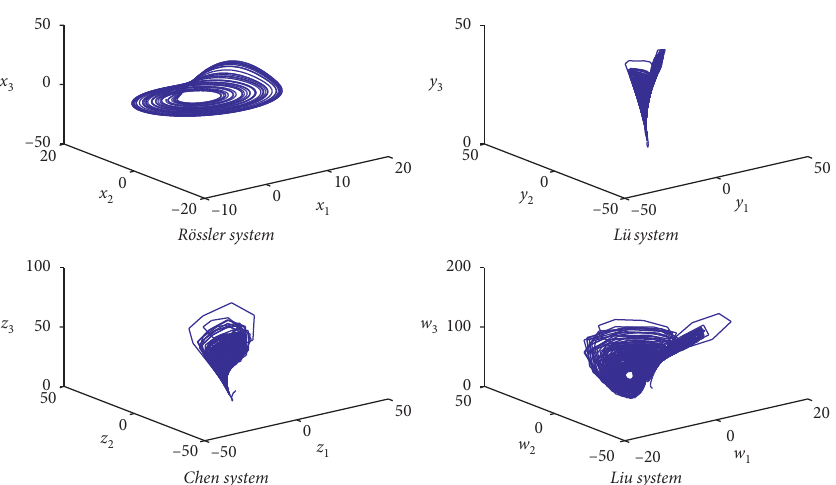
Figure 5: Chaotic attractor of several chaotic systems commonly used in chaotic secure